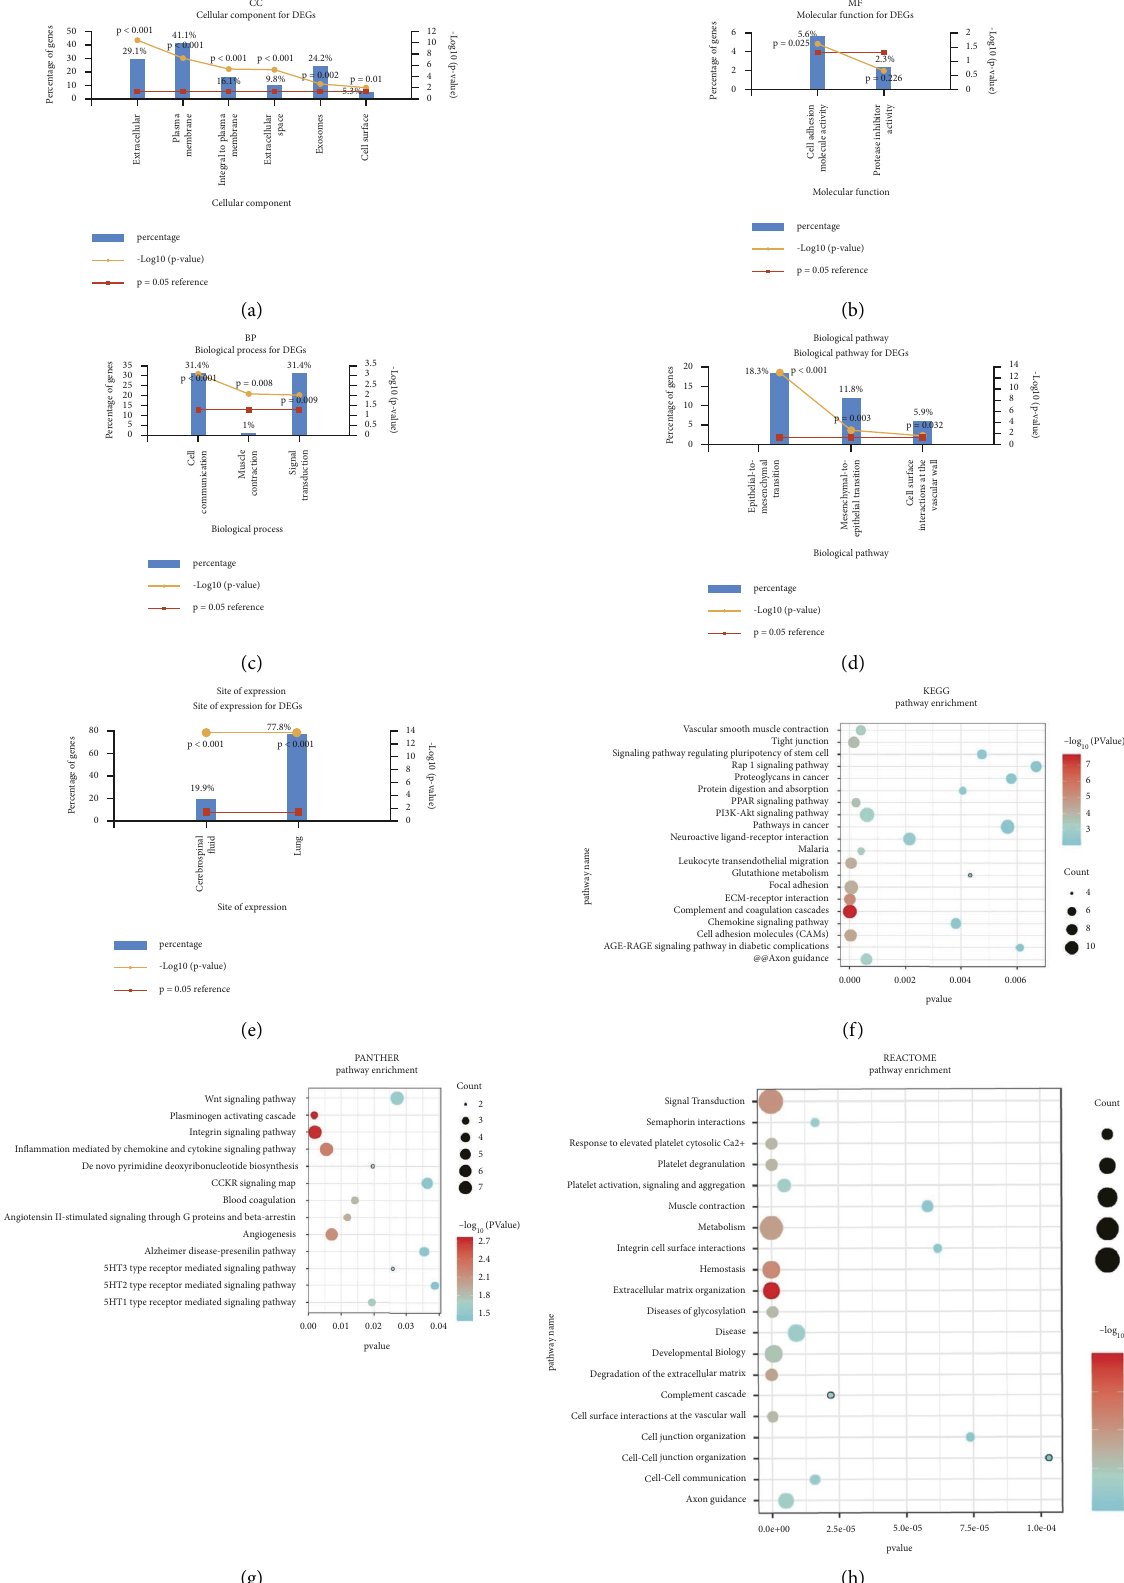
Figure 3: Pathway analysis of DEGs based on FUNRICH software. (a–e) GO analysis of CC, MF, BP, biological pathway, and site of expression. (f–h) Bubble diagram of KEGG, PANTHER, and the REACTOME pathway of lung adenocarcinoma. Signifcant pathways with P value < 0.05 and top 20 were plotted by R